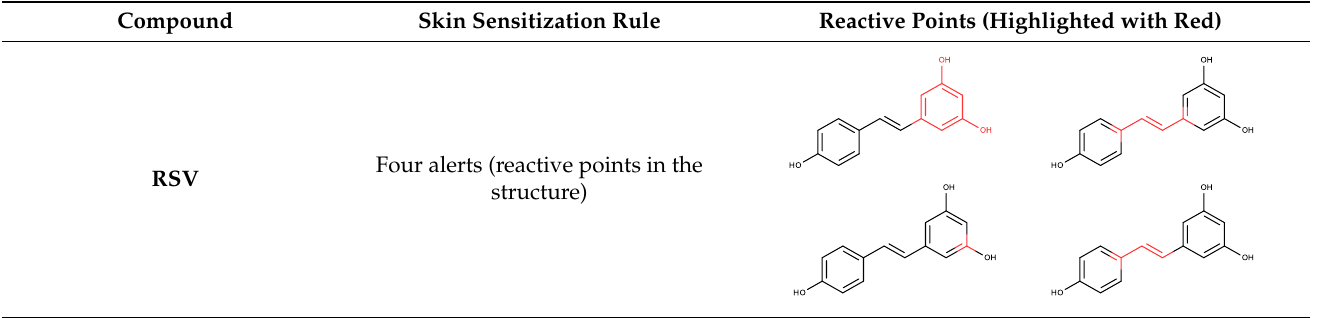
Table 1. In silico results for skin sensitization and skin irritation potential obtained from ADMETLab 2.0 software.